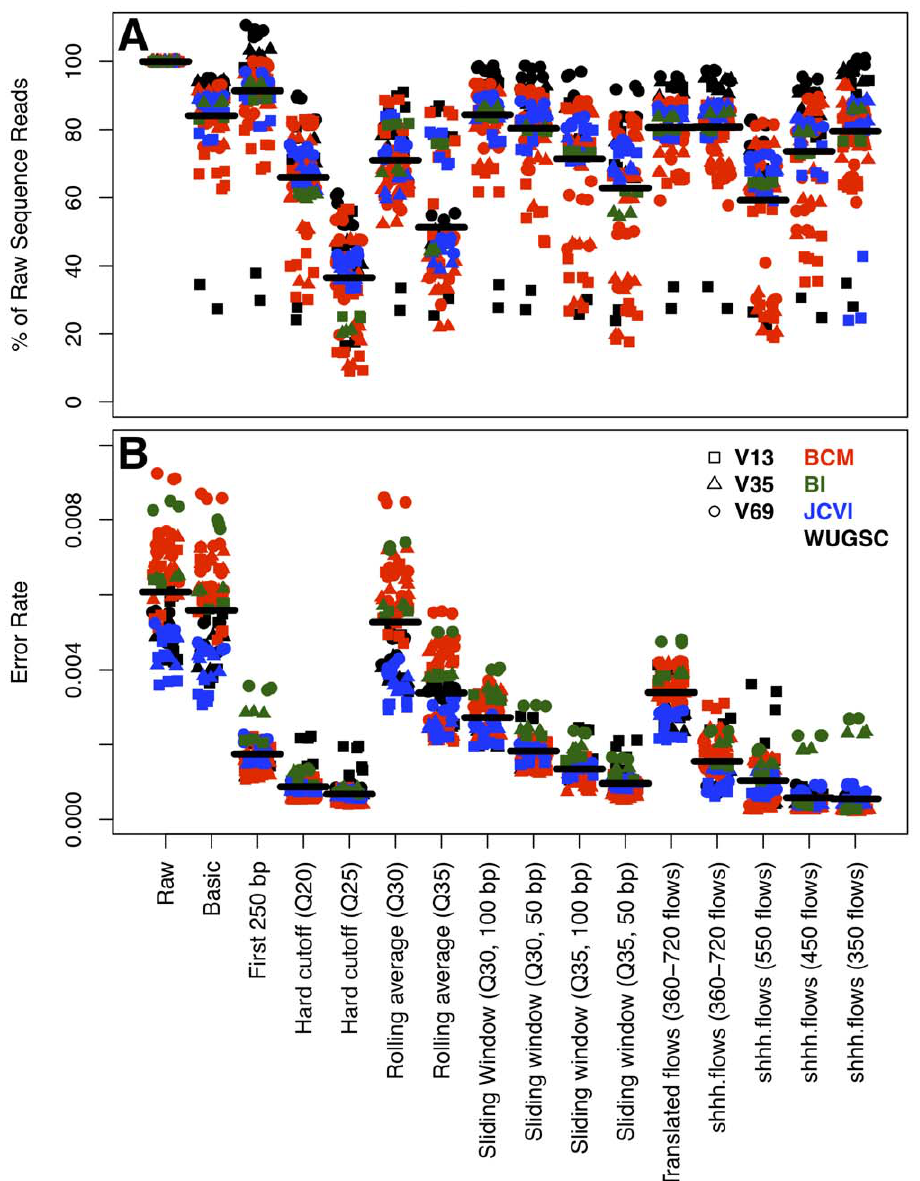
Figure 1. Effect of various sequence culling, trimming, and de-noising strategies on the number of non-chimeric reads that were longer than 200 bp and their error rates using sequence data generated by sequencing the 16S rRNA gene sequence of the same mock community. The horizontal lines represent the average across all samples within that treatment.